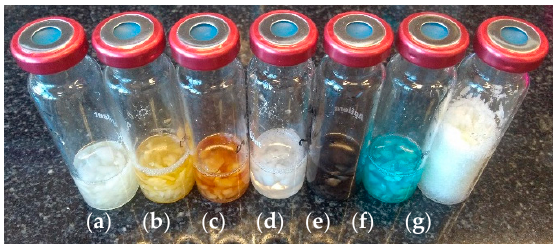
Figure 4. Kohlrabi matrix samples with addition of sinigrin potassium salt after GC/MS analysis ( a ) control (H 2 O); ( b ) iron(II) sulfate (FeSO 4 ); ( c ) iron(III) sulfate (Fe 2 (SO 4 ) 3 ); ( d ) saturated solution of calcium chloride (CaCl 2 ); ( e ) silver nitrate (AgNO 3 ); ( f ) copper sulfate (CuSO 4 ); ( g ) anhydrous sodium sulfate salt (Na 2 SO 4 ).